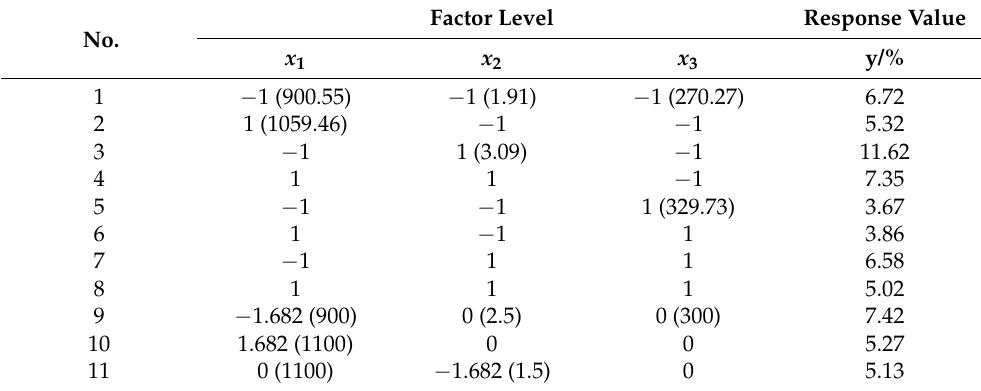
Table 4. Test factor code table.